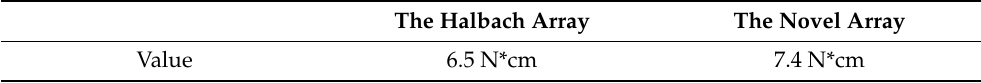
Figure 13. Ripple ratio of the driving force.